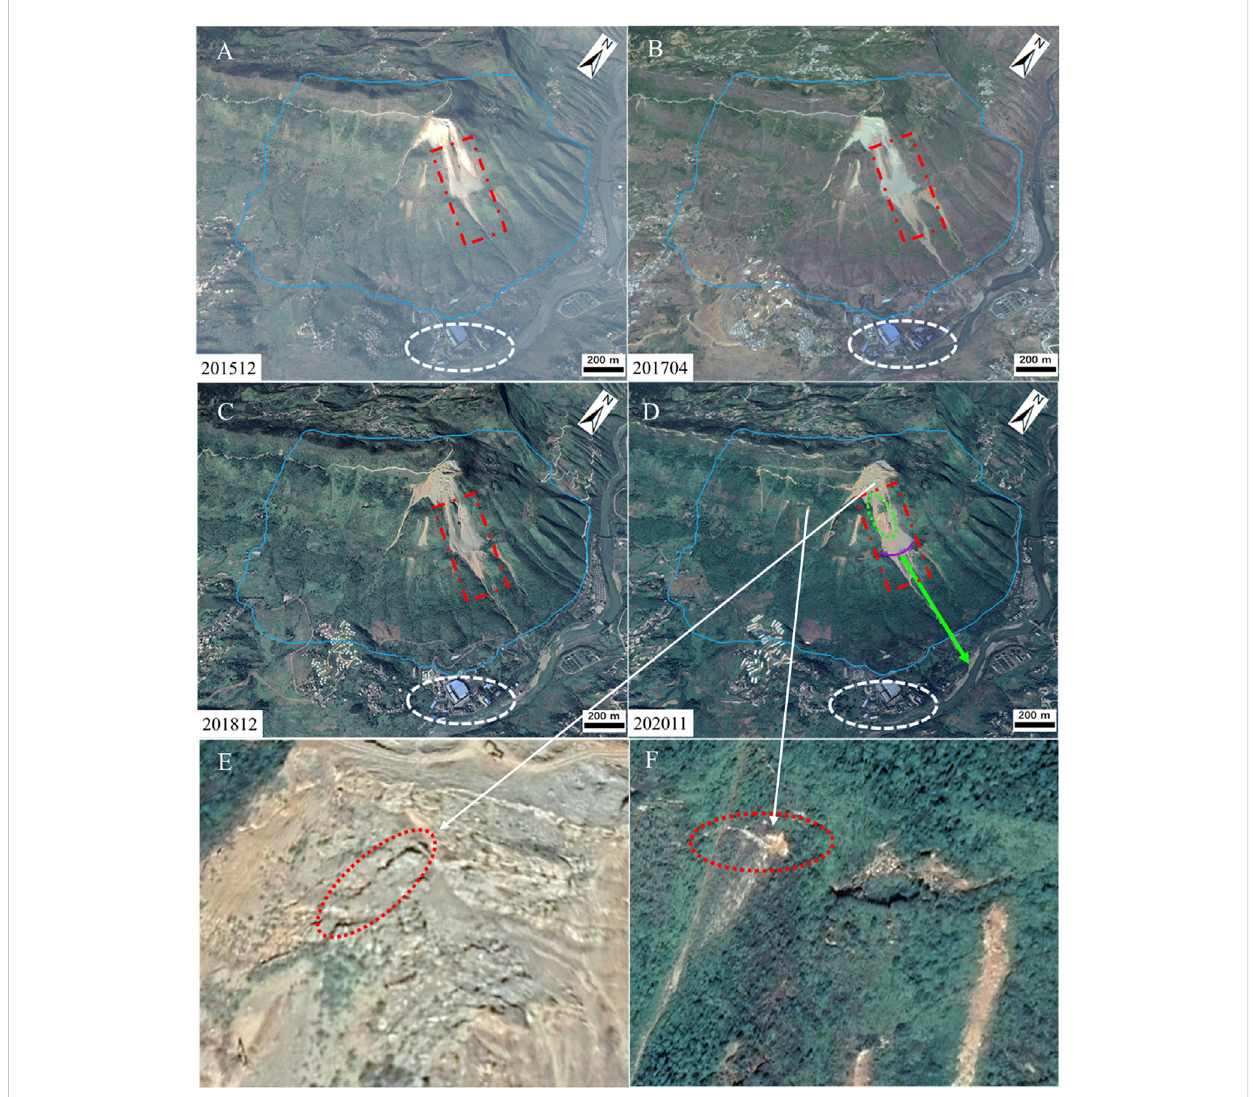
FIGURE 7 HistoricalopticalremotesensingimagesofthePingdilandslide.Thebluesolidpolygonin (A – C) and (D) indicatestheboundaryofthelandslide;The white ellipse in (A – C) and (D) indicates the mine site; The red rectangular in (A – C) and (D) is a small debris fl ow; The green circle in (D) indicates one big exposed rock; The green arrow in (D) indicates the suspected sliding direction; The red circles in (E) and (F) indicate surface